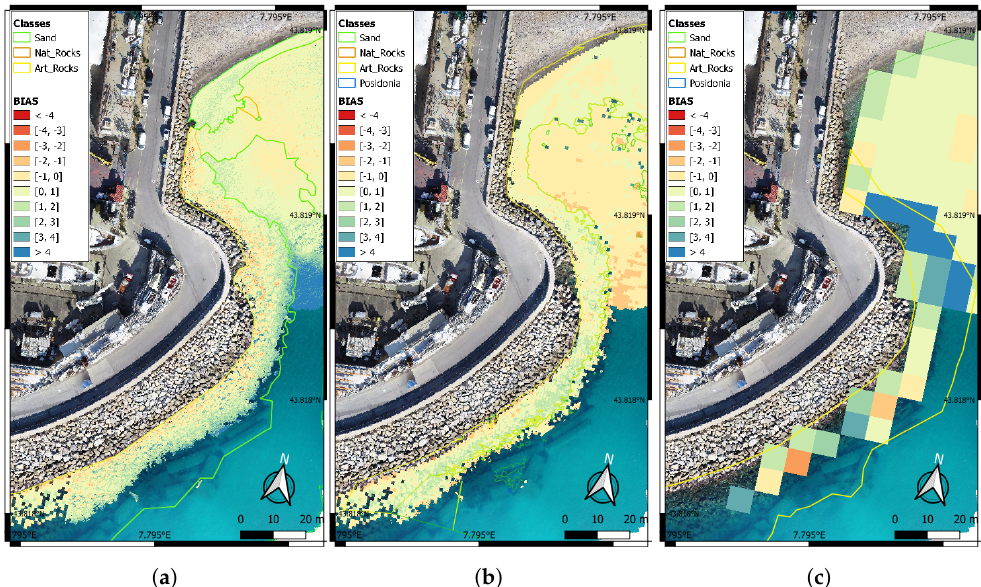
Figure 22. BIAS maps comparing the differences between the resampled MBES surfaces and RDB results for ( a ) UAV, ( b ) aircraft and ( c ) S-2 orthophotos, showing difference values at three different resolutions, 0.1 m, 1 m and 10 m, respectively. The UAV-derived orthophoto is used as background. Portosole extended area (beach area